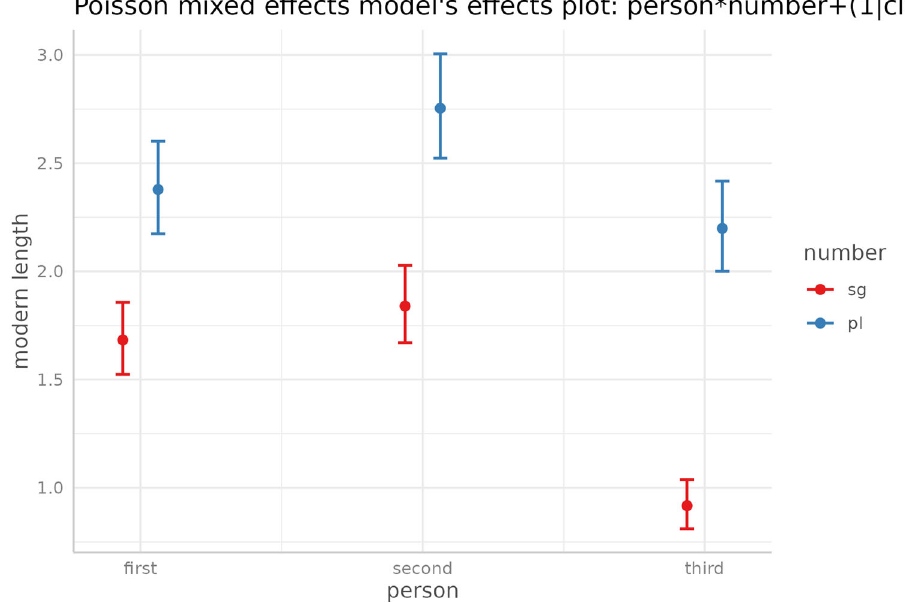
Fig. 2 Predictions of the Poisson mixed effects model for the number of segments based on person and number (clade is used as a random